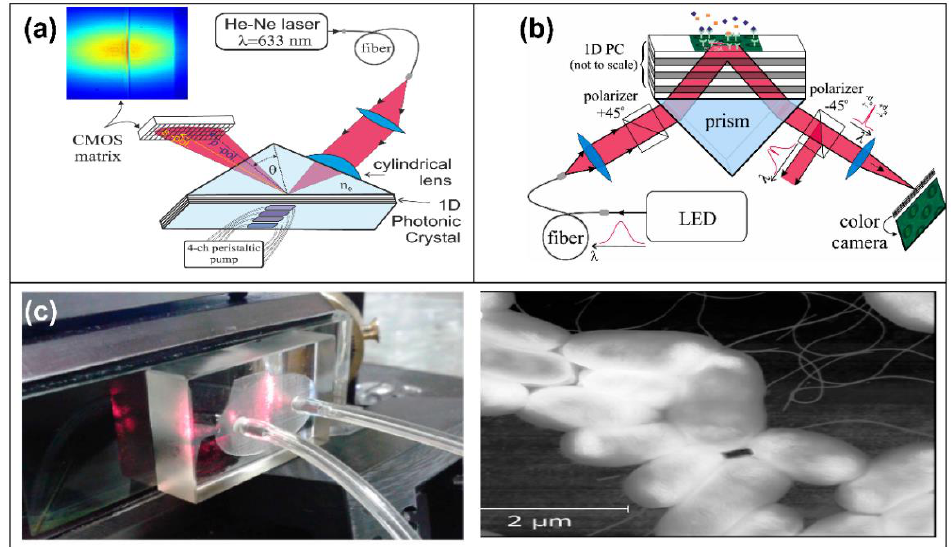
Figure 8. One-dimensional PhC biosensors: ( a ) Biosensor based on angle interrogation of a photonic crystal surface mode. ( b ) Schematic of the PhC SMi biosensor. Typical spectra of light as it passes from the LED to the color camera are shown. ( c ) A photograph of the flow cell and the photonic crystal behind it is attached to the prism via a refractive index matching oil and a topography atomic force microscopy (AFM) image of E. coli with flagella attached to the photonic crystal chip. ( a ) Reprinted with permission from [105], copyright 2019, Nature; ( b ) reprinted with permission from [109], copyright 2020, Elsevier; ( c ) reprinted with permission from [111], copyright 2016,